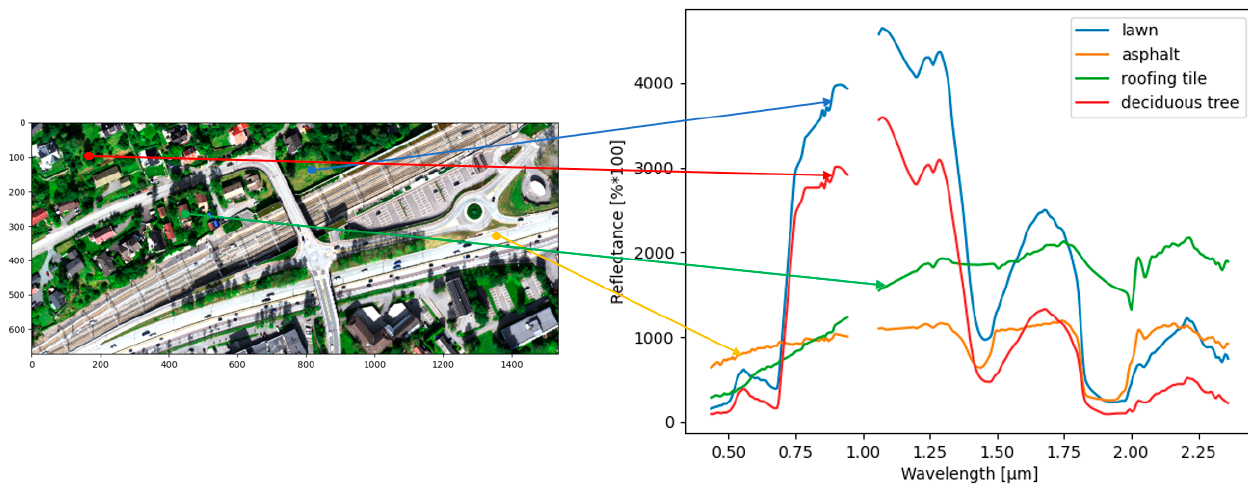
Figure 2. At surface reflectance of some urban surfaces (HySpex sensors VNIR-1800 and SWIR-384). The hyperspectral dataset was acquired by the Terratec AS Company in August 2019 over Baerum municipality, Oslo, Norway.